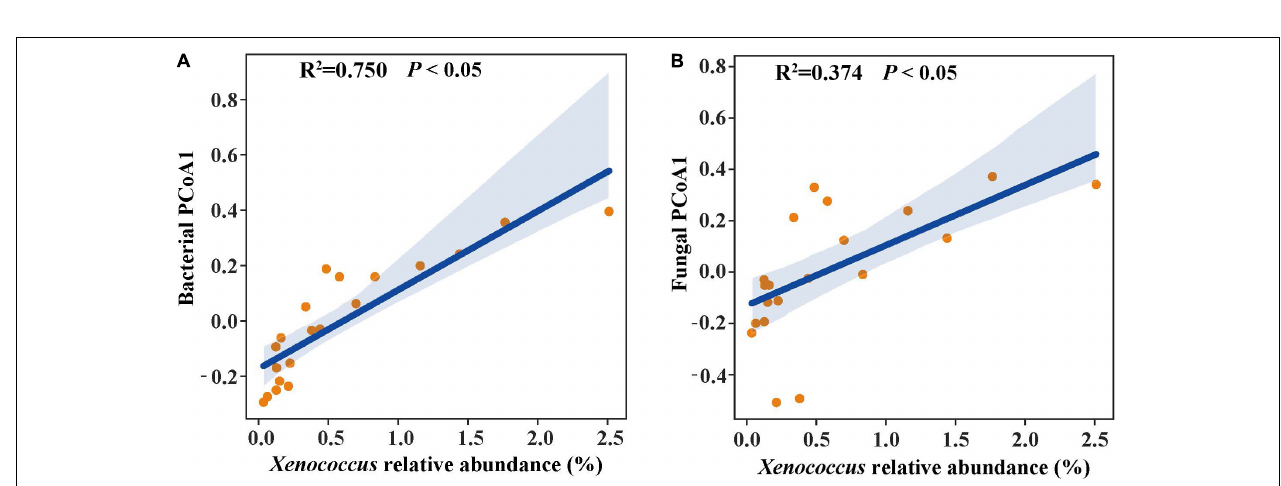
FIGURE 6 | Linear regression relationship of the relative abundance of Xenococcus with bacterial structure (A) and fungal structure (B) .